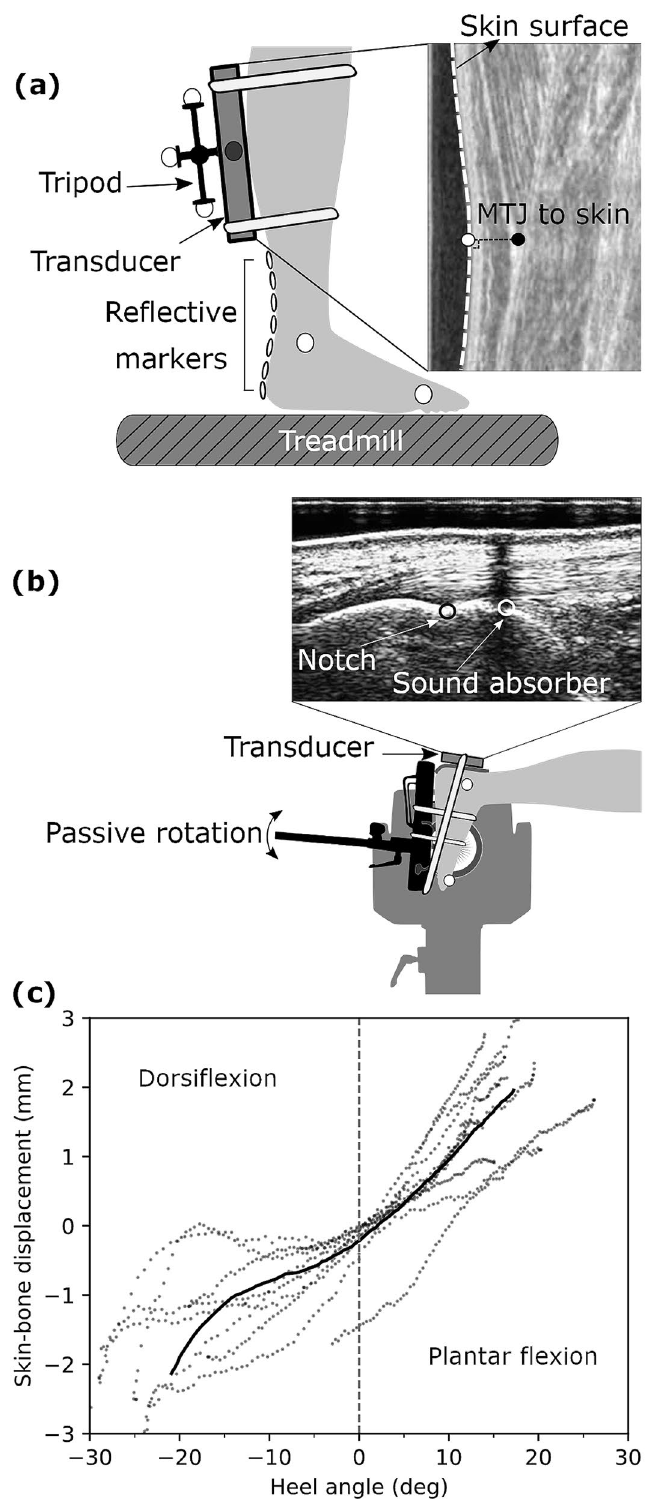
Figure 1. ( a ) Experimental setup for determining Achilles tendon (AT) length during gait. ( a ) Reflective foil markers on the skin were used to reconstruct the curve-path shape of the AT. The position of the gastrocnemius medialis myotendinous junction was projected to the skin surface, and the coordinates of the ultrasound images were transformed to the global coordinate system using a marker tripod attached to the ultrasound probe. ( b ) A three-centimeter ultrasound probe was placed on top of the calcaneus bone and a sound-absorptive marker in-between to measure the differences in calcaneus bone displacements (notch) and the skin (absorber marker) displacements as a function of the heel to shank angle. ( c ) Average (solid line) and individual (filled dots) data of skin-to-bone displacements vs. heel angle. Positive heel angles represent plantar flexion, and negative ones are dorsiflexion (eleven participants with three